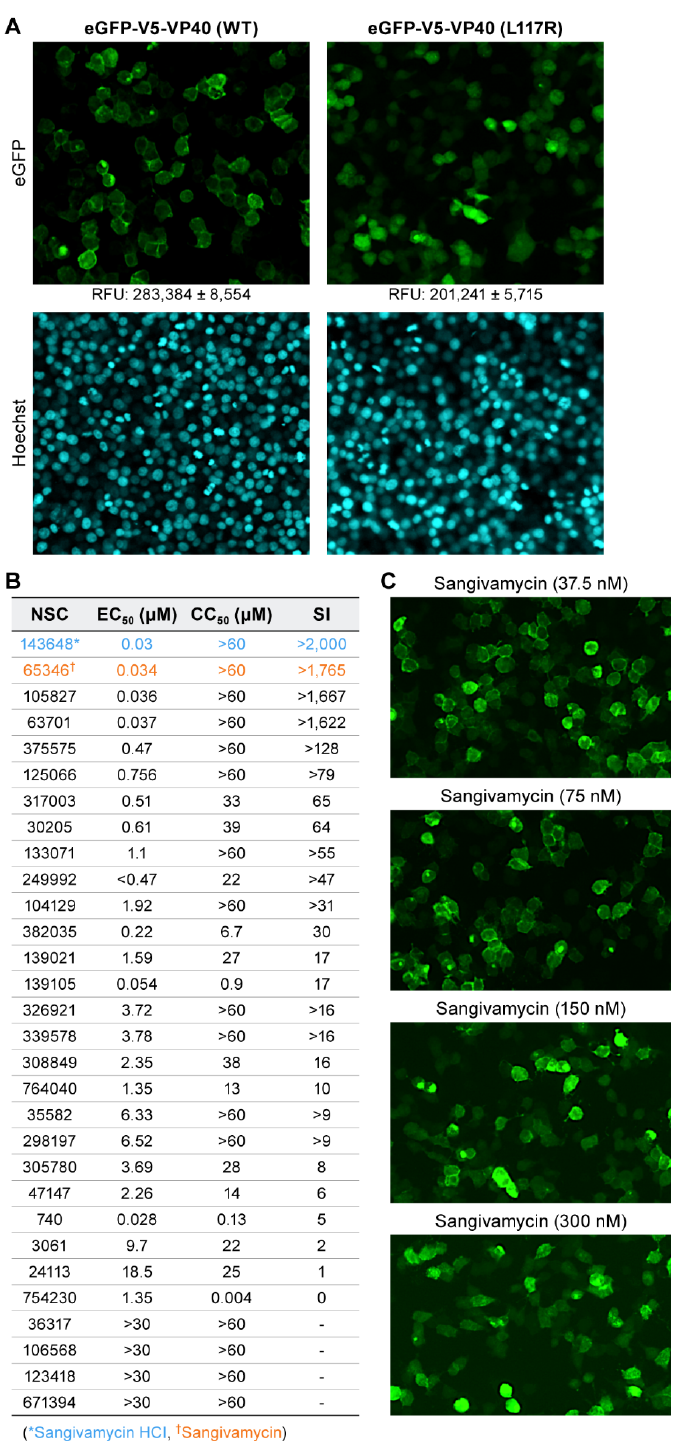
Figure 2. EBOV VP40 membrane localization is disrupted by sangivamycin. ( A ) Disruption of VP40 membrane association via the introduction of the L117R mutation (VP40 L117R positive control). Relative fluorescence units (RFUs) are shown below the eGFP images at 10× magnification. Lower RFU values for hits were then phenotypically confirmed via VP40 membrane association and fluorescent cellular rings for VP40 WT (top left panel). VP40 L117R positive control prevents initial VP40 dimerization and virion-like particle (VLP) formation leading to diffuse cellular fluorescence with lower RFU (top right panel). Hoechst 33342 DNA staining for chromatin in nuclei was used